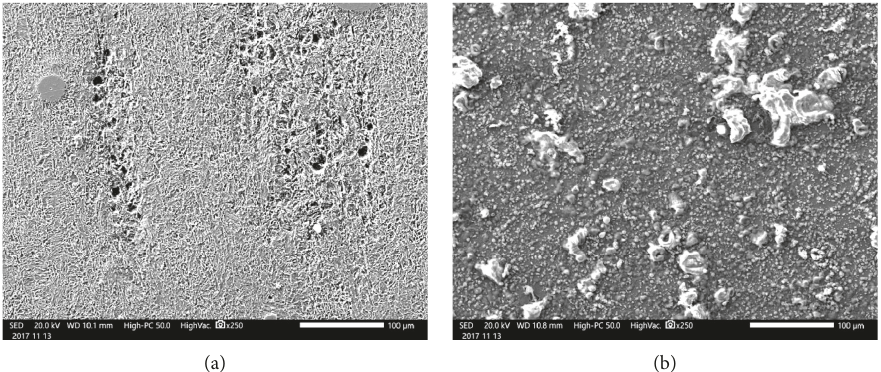
Figure 15: Morphological aspects of the surface of API X70 steel after 100 hours of immersion in a 3.5% NaCl solution at room temperature: (a) without inhibitor; (b) with 0.001 M of inhibitor synthesized from permanent